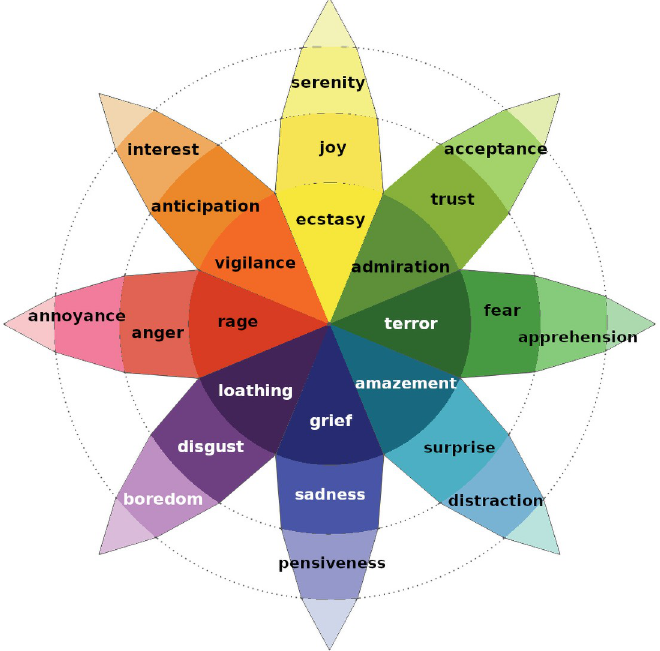
Fig 2. Plutchik’s wheel of emotions. Each petal is partitioned in three degrees of intensity, from the most intense (the most internal section) to the least intense (the most external section).